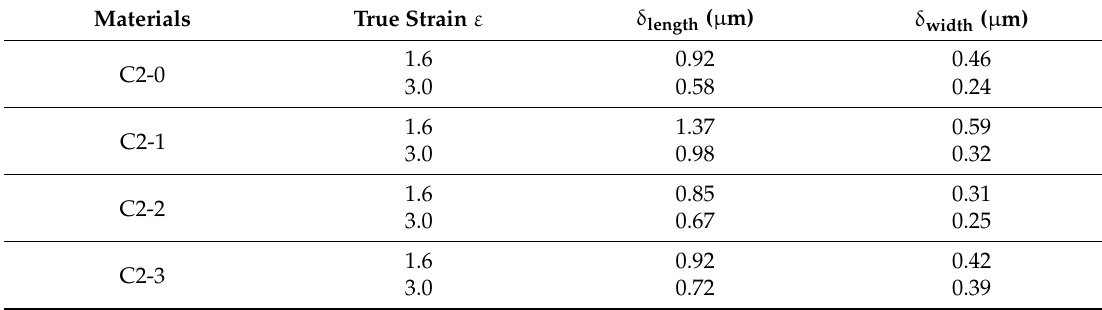
Table 4. Sub-grain sizes measured from SEM-BSE micrographs, in terms of length and width, for the different material variants after strains of ε = 1.6 and